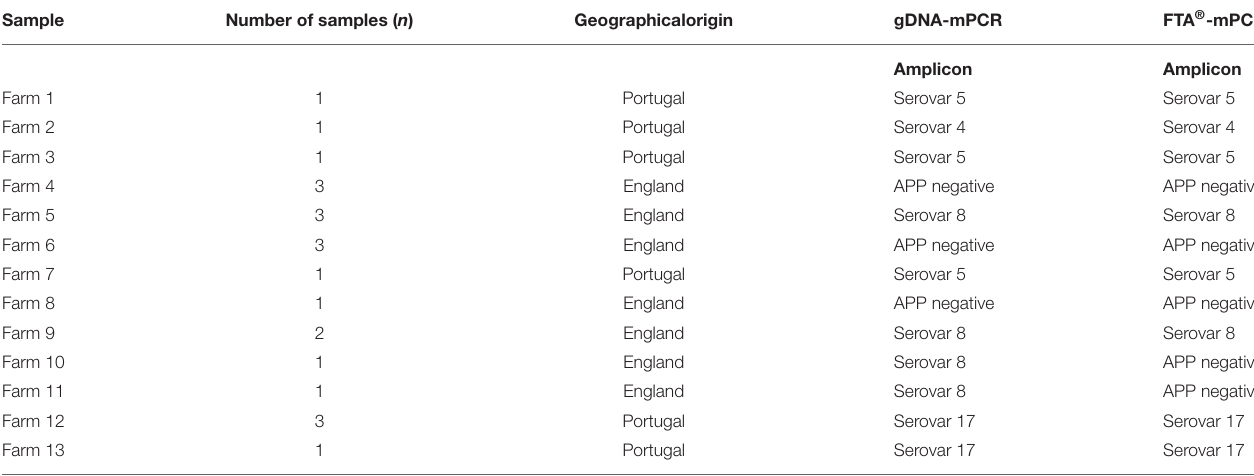
TABLE 1 | Clinical samples with suspected A. pleuropneumoniae infection. Sample